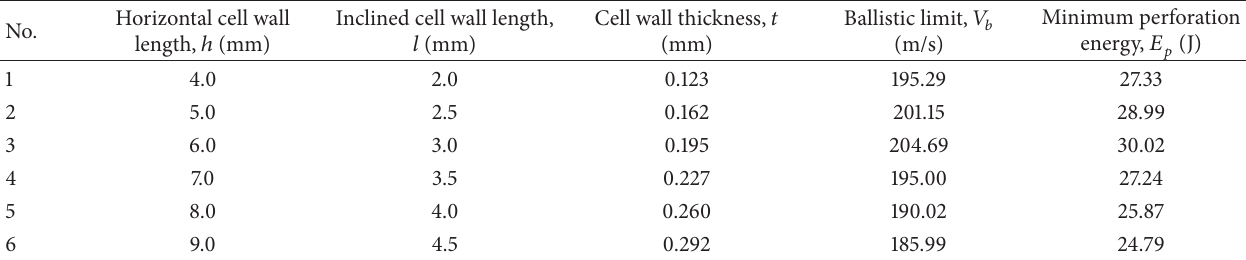
Table 5: Specifications and numerical results of a group of sandwich panels with identical mass ( 𝑇 𝑓 = 1.0 mm, 𝑇 𝑐 = 50 mm and 𝜌 = 0.15) and unit cell angle ( 𝜆 = − 30 ∘ ), but different cell wall lengths and thicknesses, so that the effects of cell size and wall thickness can be studied.